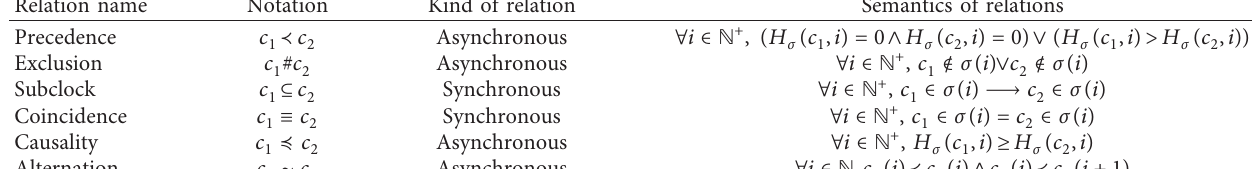
Table 1: The semantics of clock relations.